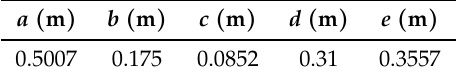
Table 1. Constant parameters of the model.